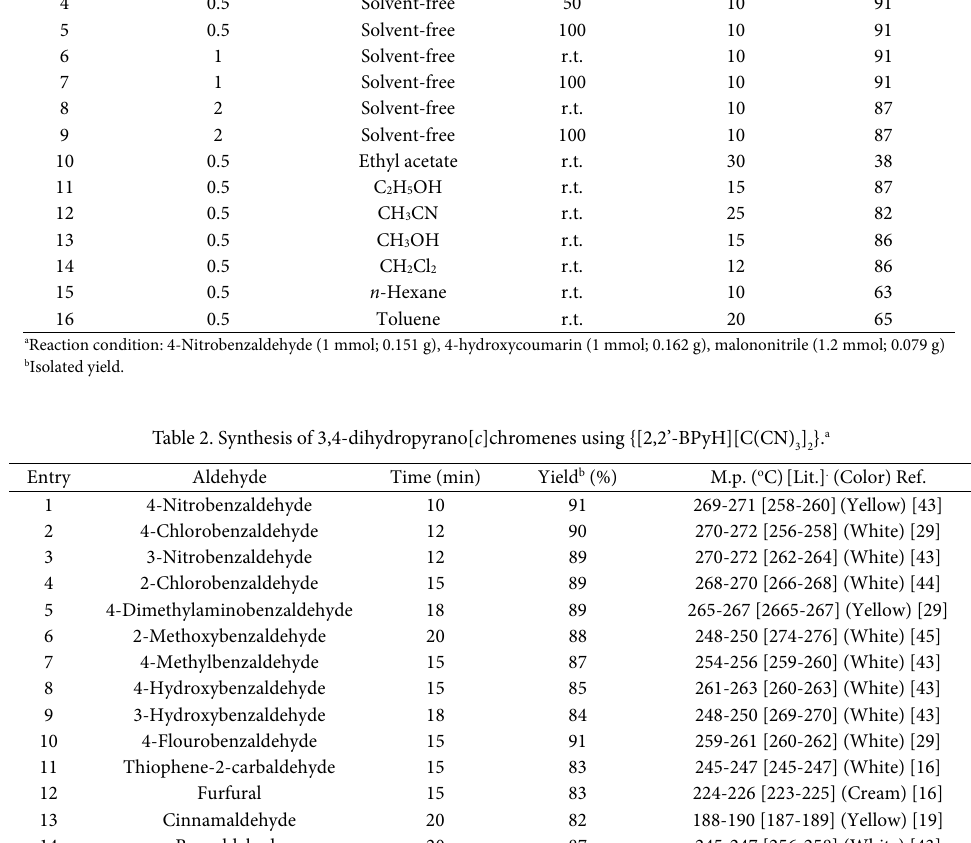
Table 1. Optimizing the reaction condition in the synthesis of 3,4-dihydropyrano[ c ]chromenes. a